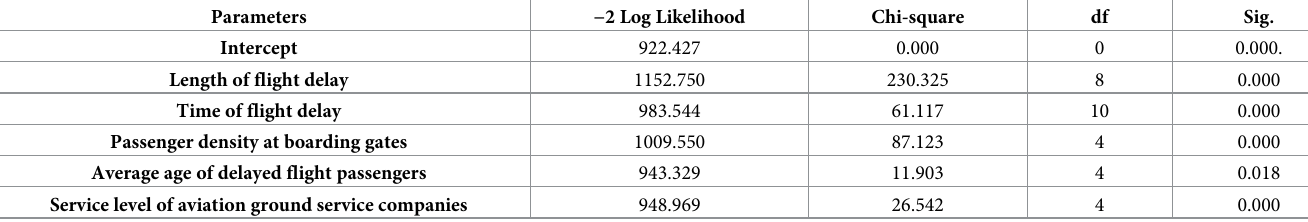
Table 7. Maximum likelihood ratio test of